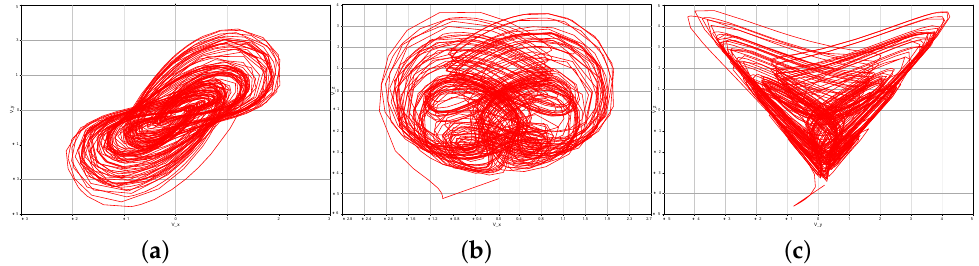
Figure 5. Chaotic attractor phase diagram for the hyper-chaotic Bao-like system based on memristor with the initial condition x ( 0 ) = [ 1,1,1,1 ] T . ( a ) x - y plane. ( b ) x - z plane. ( c ) y - z